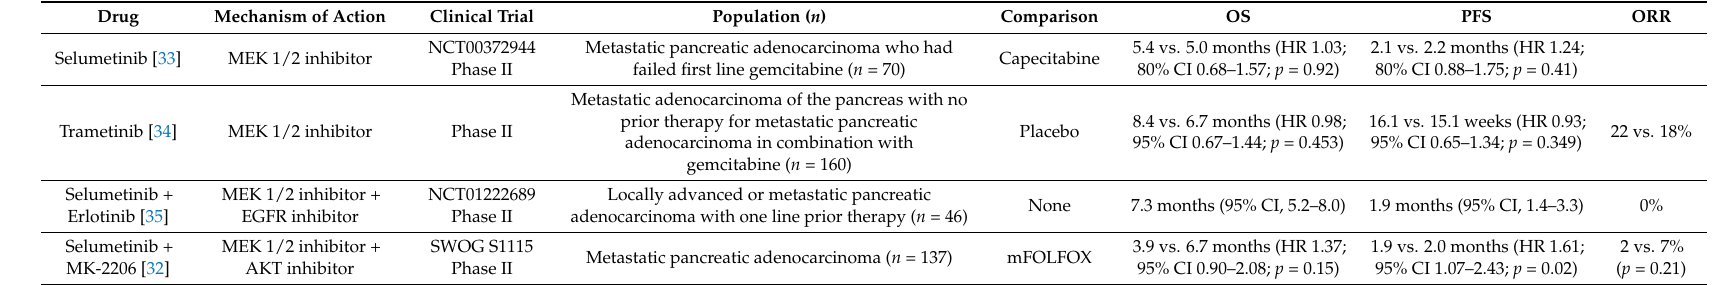
Table 2. Select trials targeting downstream of